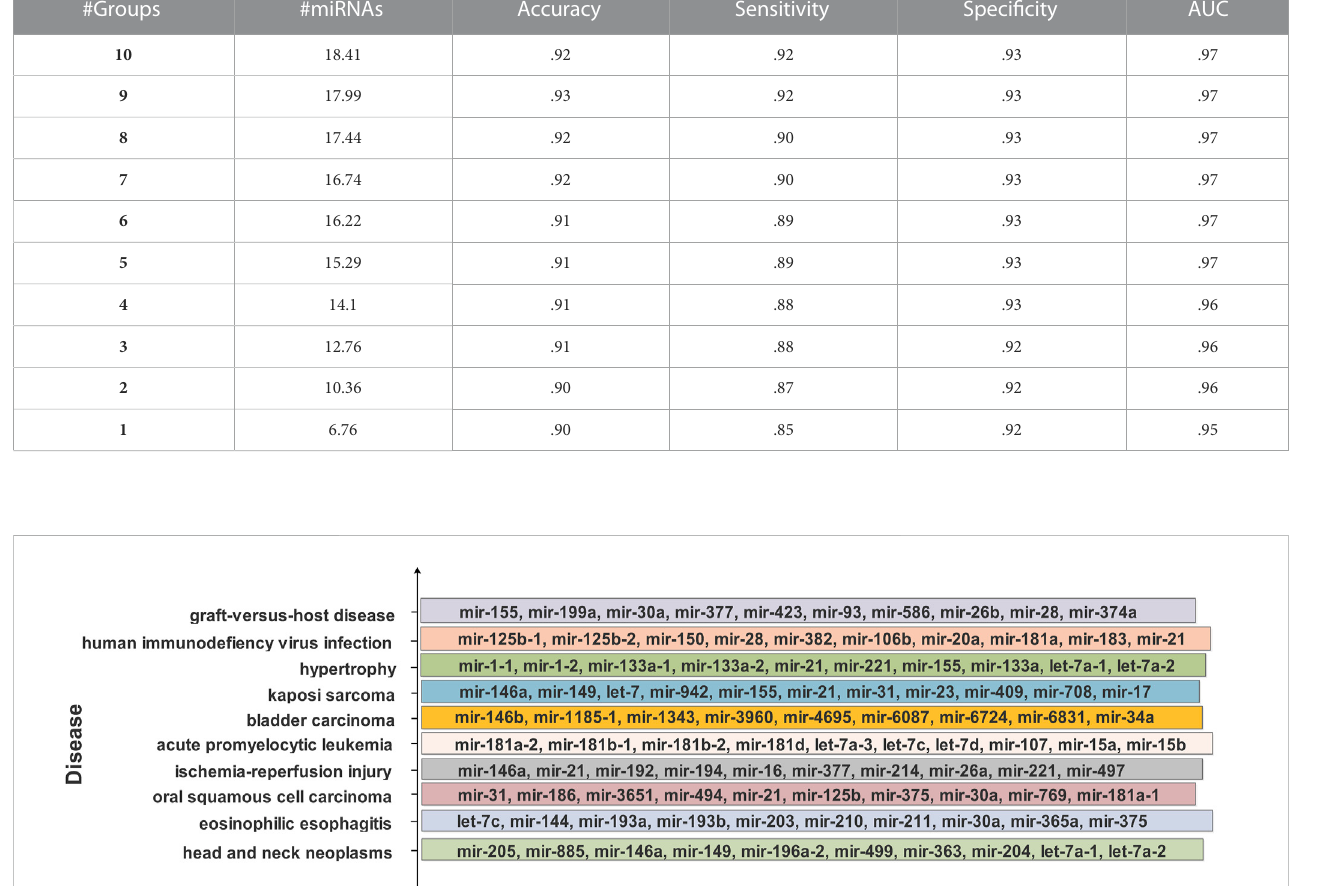
TABLE 4 A sample average table of 100-fold MCCV performances from miRdisNET for the top 10 ranked groups for the BLCA dataset cumulatively. #Groups